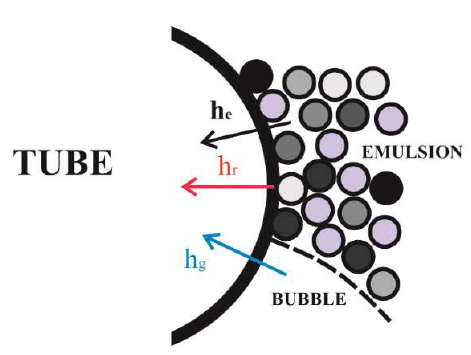
Figure 2. Different heat transfer mechanisms between a fluidized bed and an immersed horizontal